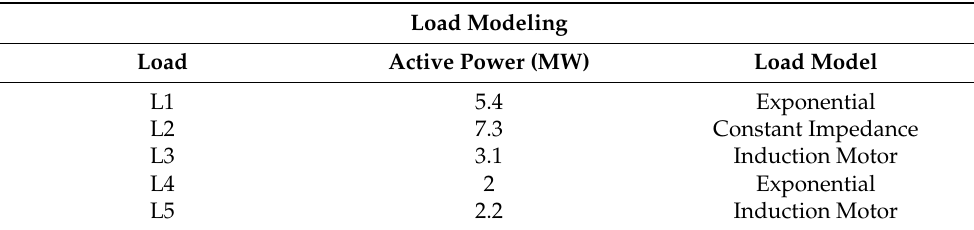
Table 2. Static and dynamic load distribution.